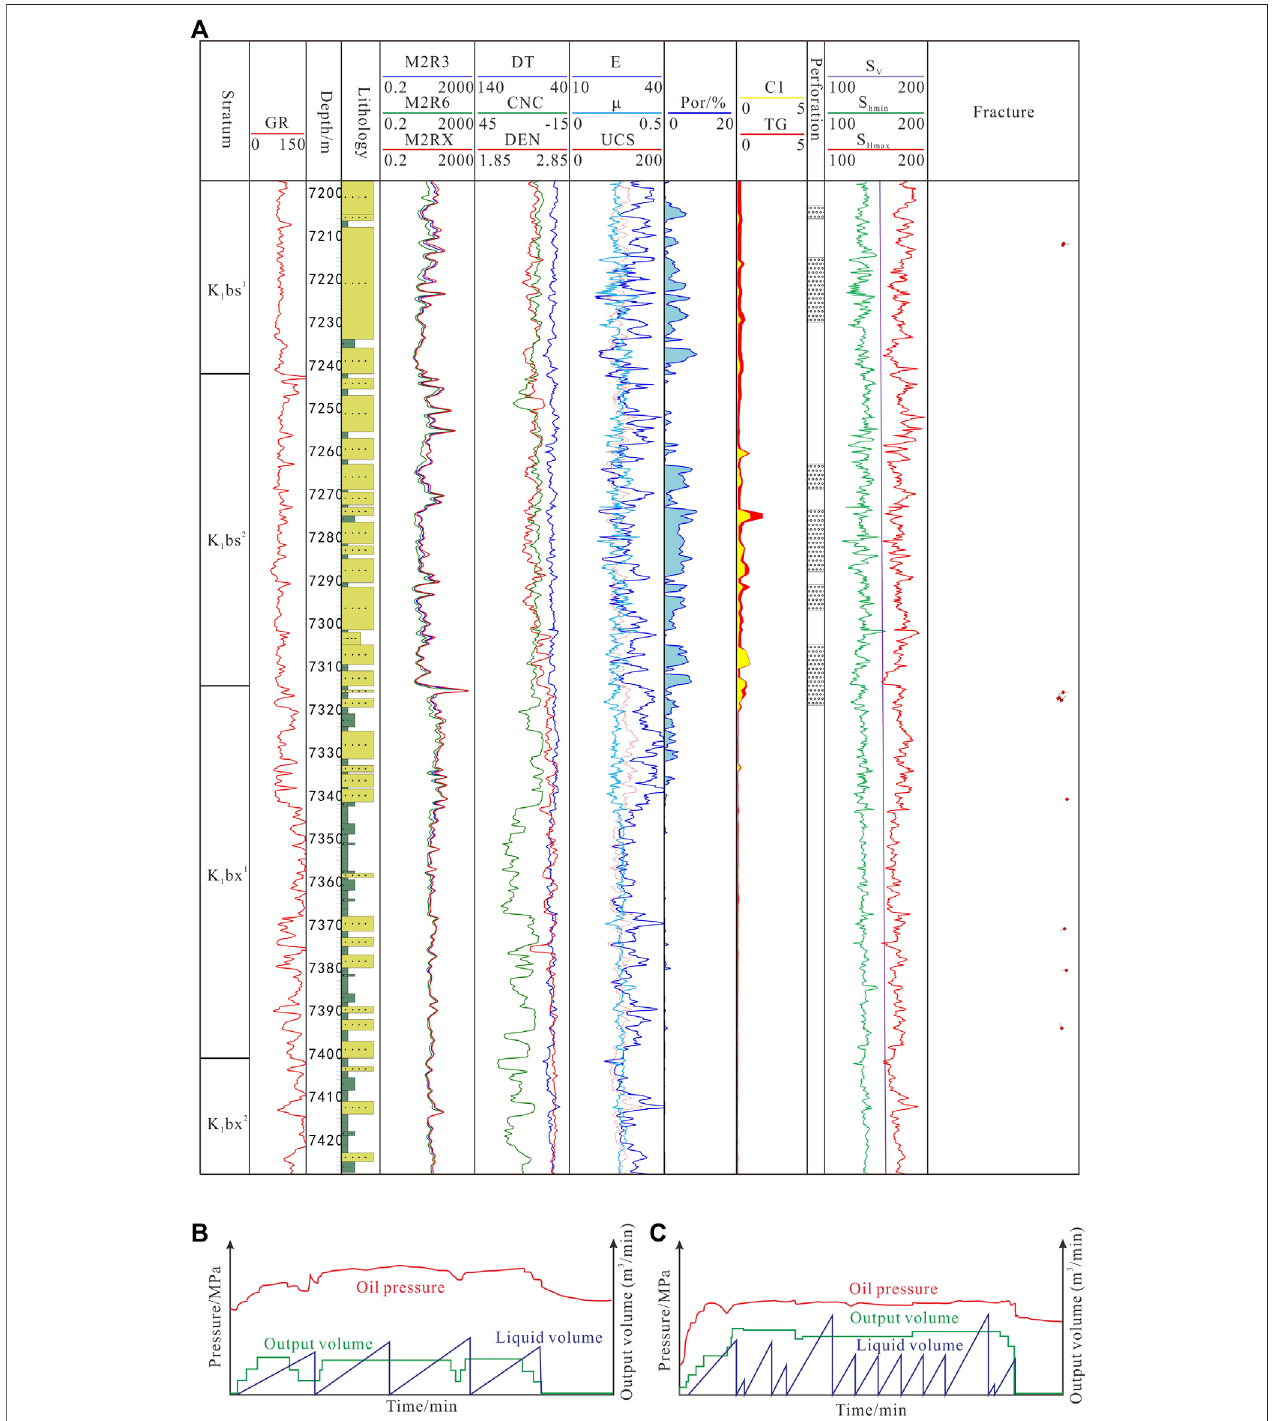
FIGURE9| Geomechanicalcolumnand fracturing curve ofWellks10X. (A) isone-dimensional geomechanics andfracturedevelopmentpro fi le ofwellks10x. Only twonaturalfracturesaredevelopedin7200-7310msection;Eightnaturalfracturesaredevelopedinthe7310-7400msection.Theoverallstressoftheshaftishigh,and the minimum horizontal principal stress exceeds 140 MPa. From the perforation position, four natural fractures are developed at 7263-7320 m of the fi rst fracturing section; However, natural fractures are not developed in the 7203-7239.5 m perforated interval of the second fracturing section. (B) is the fracturing construction curve of 7263-7320 m formation, (C) is the fracturing construction curve of 7203-7239.5 m formation.